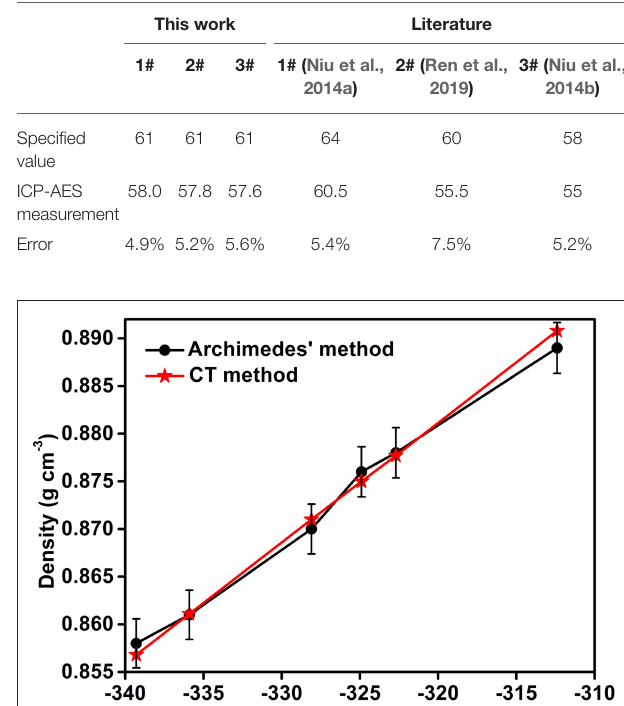
the performance of ICP-AES and the density test results (see later).